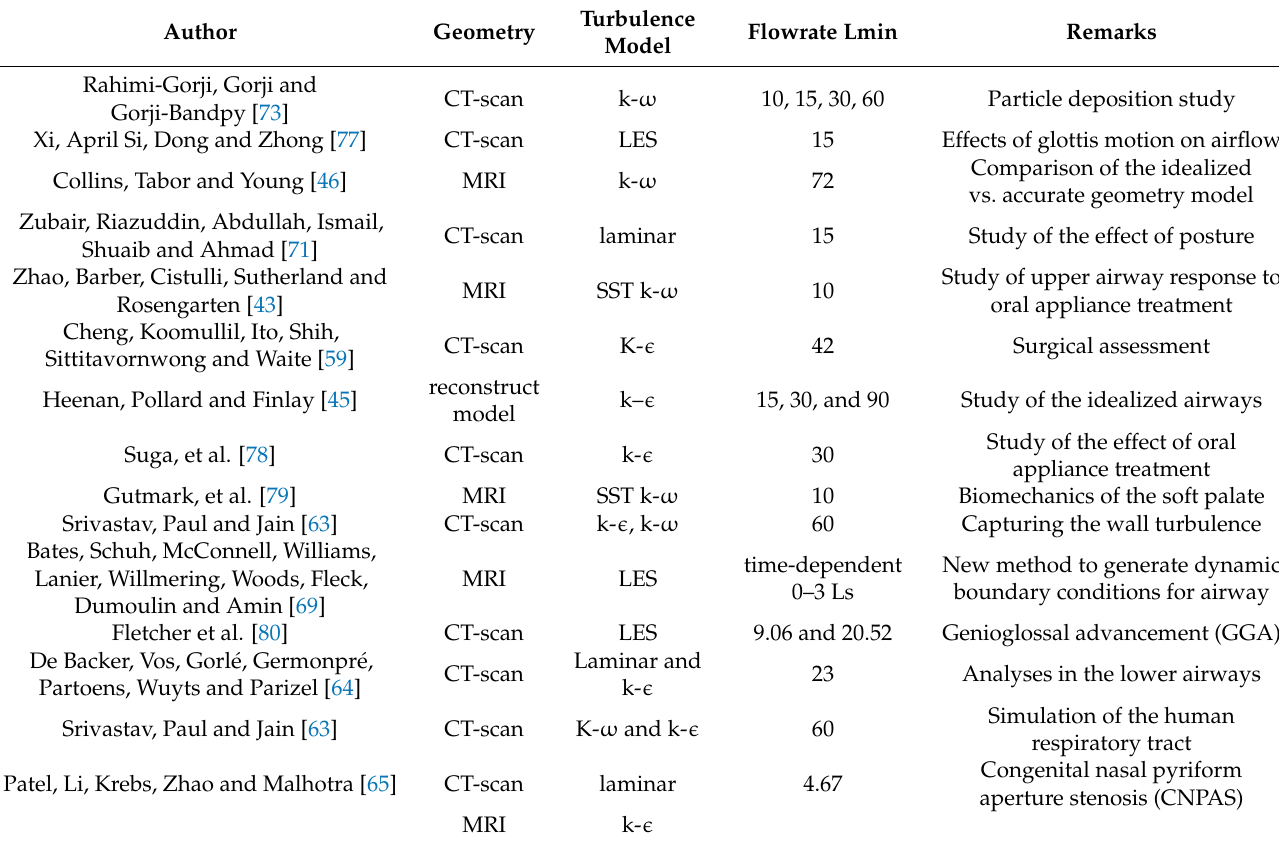
Table 2. Compilation of methods used for CFD modelling of the